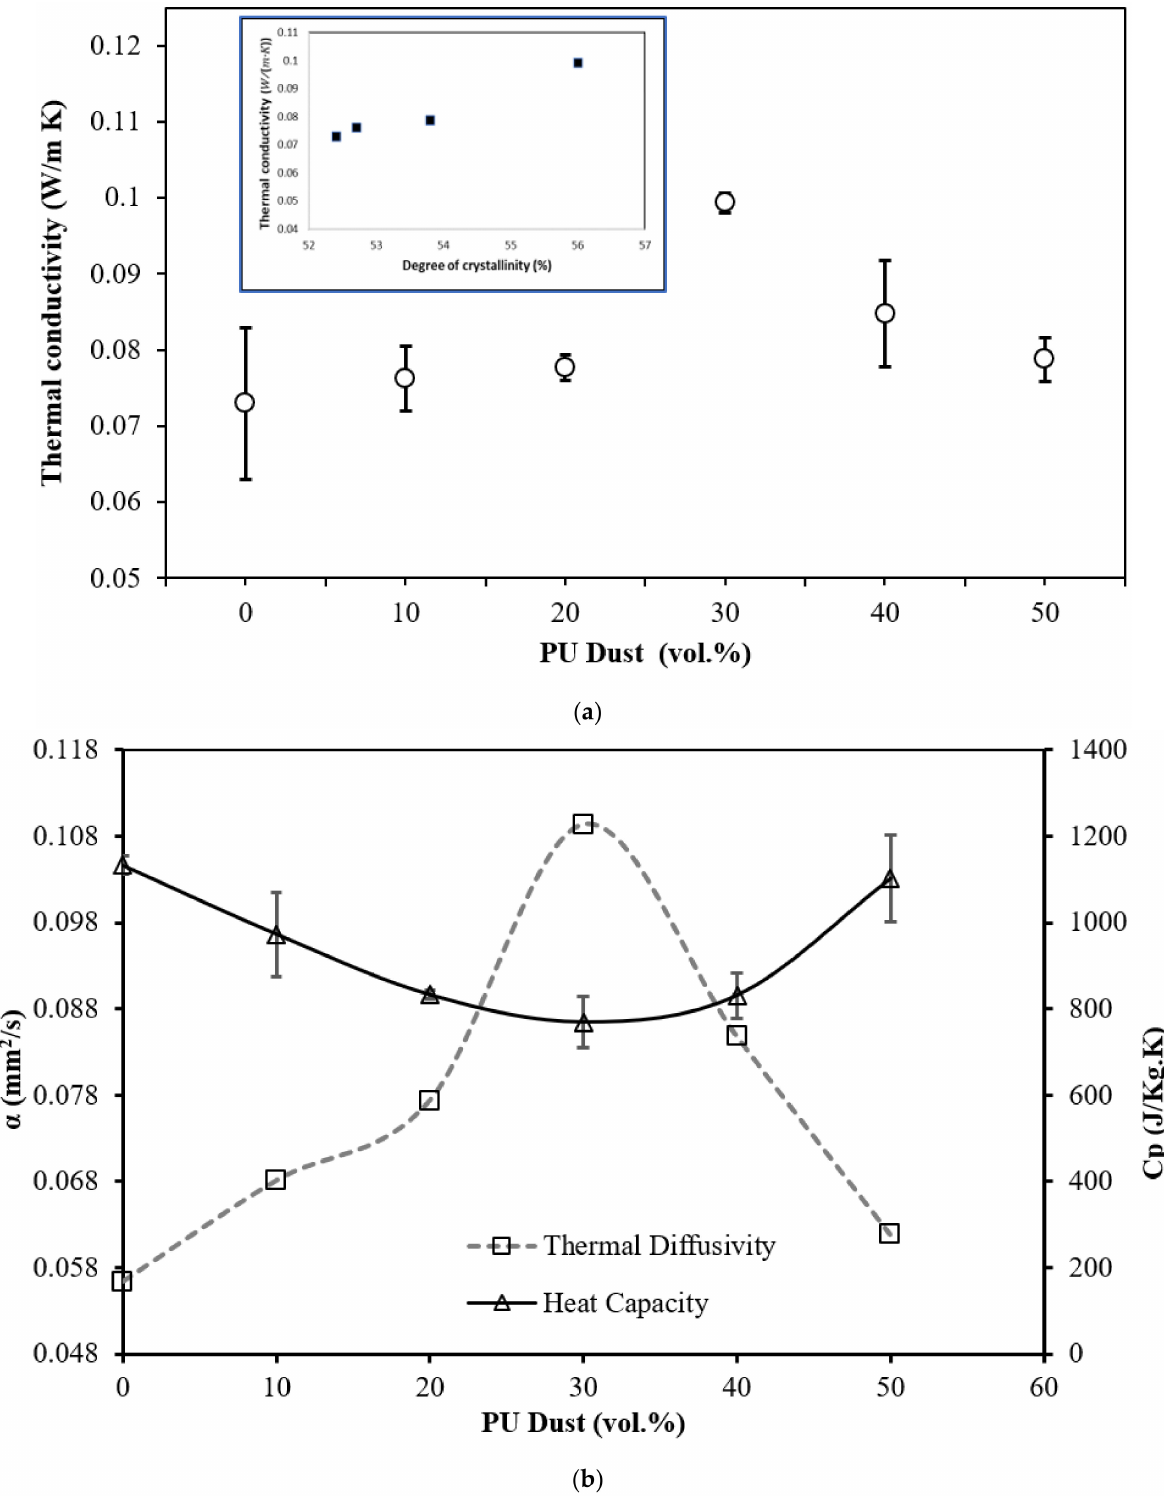
Figure 6. ( a ) Thermal conductivity and ( b ) heat capacity and thermal diffusivity of UPR-PUD